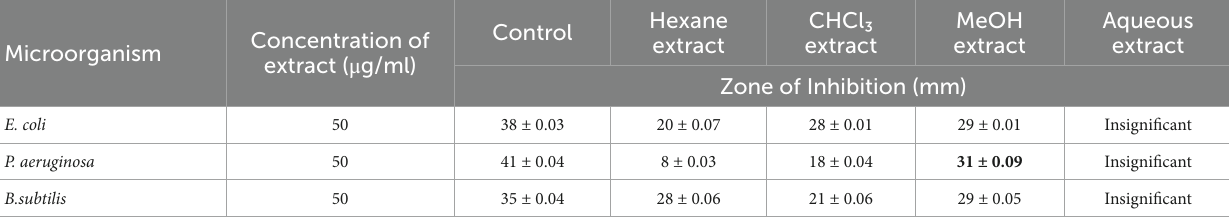
TABLE 4 Zone of inhibition (Stem